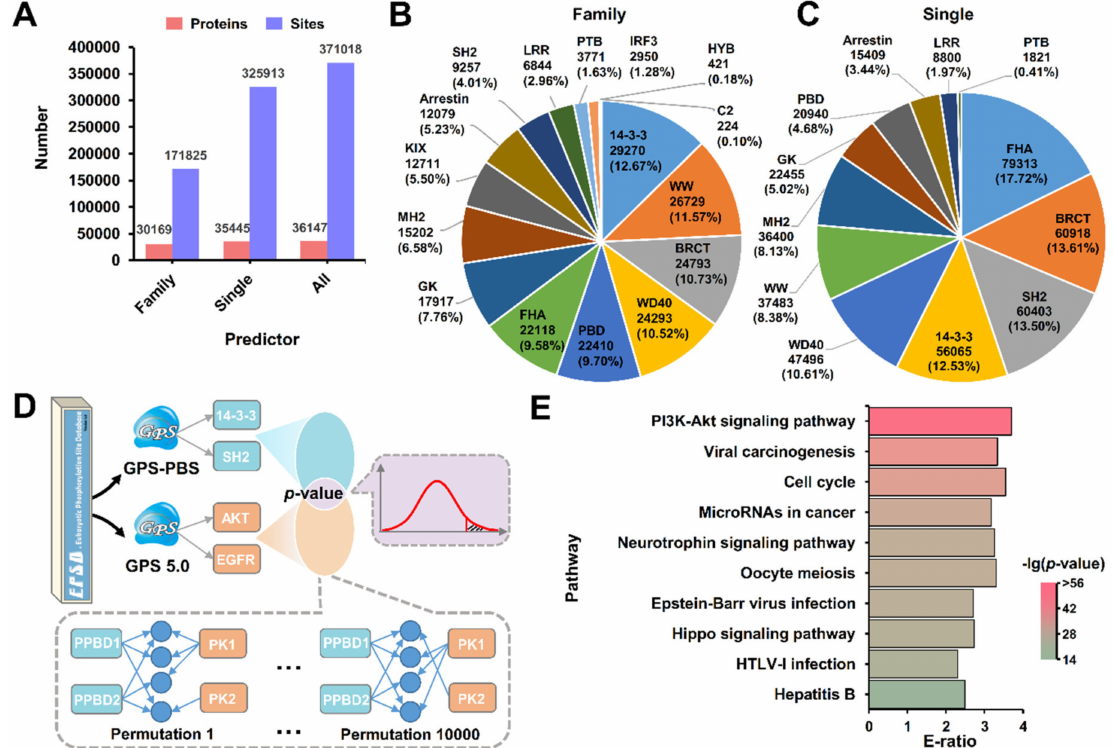
Figure 5. A large-scale prediction of potential PPBDs from a mammalian phosphoproteomic data set. ( A ) From 765,779 mammalian p-sites obtained from EPSD [44], GPS-PBS predicted potential PBSs using family-based and / or single PPBD cluster-based predictors. The family distribution of numbers of potential PBSs were shown for ( B ) the family-based predictions, and ( C ) the single PPBD cluster-based predictions. ( D ) After identification of potential DRPs, the significant associations between PPBDs and PKs in regulating the same p-sites were detected through a permutation test ( p -value < 10 -10 ). ( E ) The KEGG-based enrichment analysis of DRP-containing proteins against all predicted